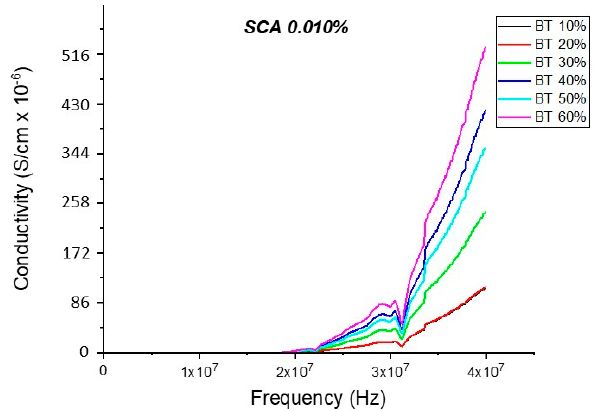
Figure 20. The conductivity of the BaTiO 3 -epoxy composite that were fabricated using BaTiO 3 nanoparticles which were surface modified using 0.010 SCA is plotted as a function of frequency. The maximum value of conductivity at 20 MHz is 4.63 × 10 − 4 S / m and occurs at BT